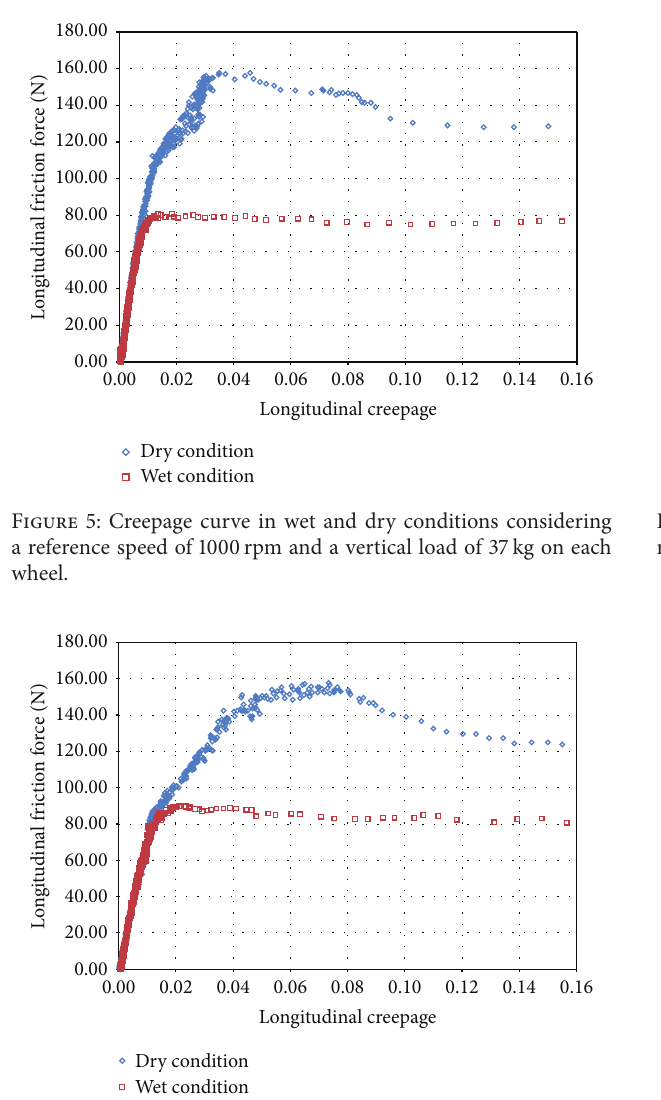
Figure 6: Creepage curve in wet and dry conditions considering a referencespeedof700 rpmandaverticalloadof37 kgoneachwheel.